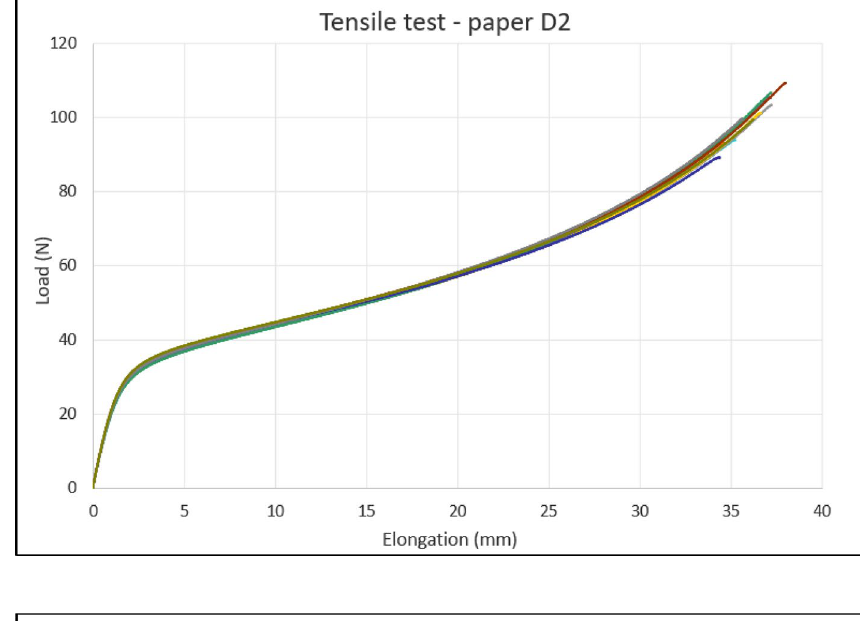
Fig. 33 Force elongation curves of individual specimen of paper